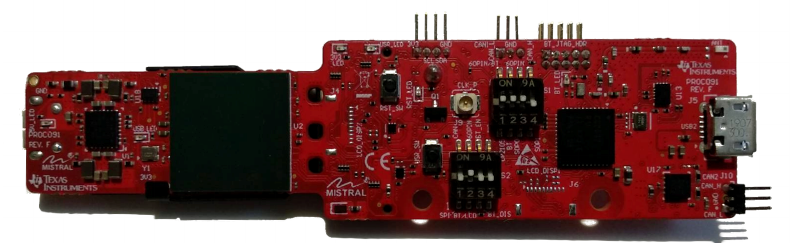
Figure 7. Evaluation module IWR6843AOPEVM (Rev. F), photographed from the front side.